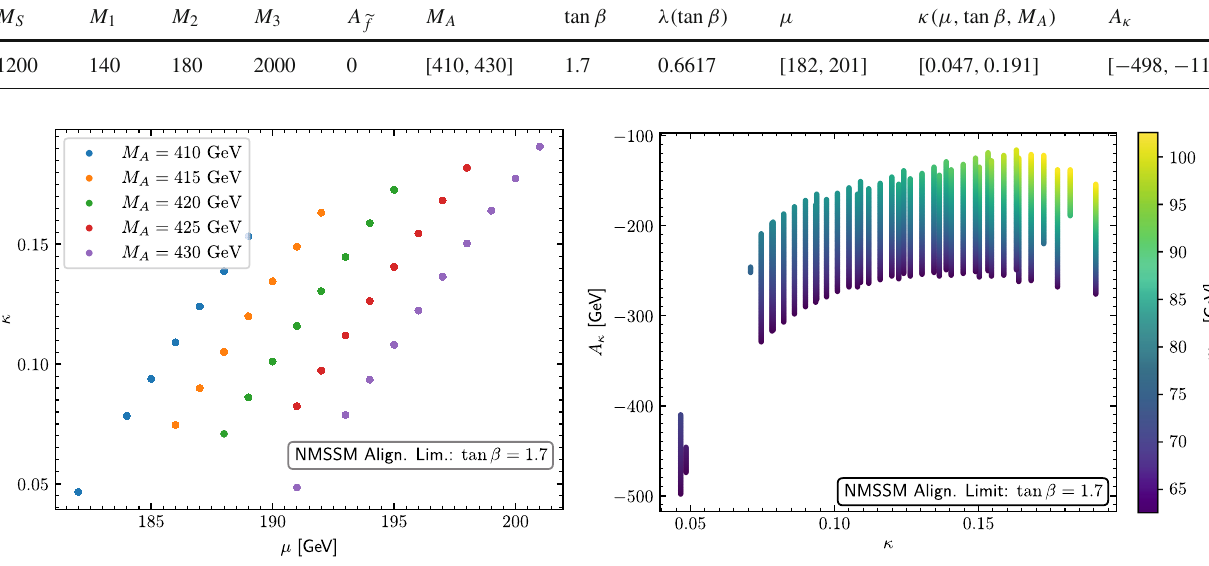
Fig. 12 NMSSM parameter points with χ 2 ≤ χ 2 in the μ – κ plane (left) and in the κ – A κ plane (right). The colors of the points indicate the value SM of the tree-level mass parameter M A (left) and the mass of the CP-even singlet-like Higgs boson m h (right) S EW sector of the model. Concerning the colors of the points, indicating M A , one should note that each point in the plot corresponds to a subset of parameter points with different values of A κ . One can see that for increasing values of M A also larger values of μ and κ are required in order to fulfill the second alignment